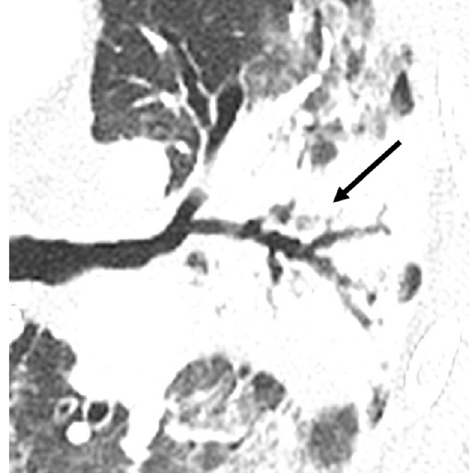
Fig. 15 Staphylococcus epidermidis . Sepsis. Consolidation with air bronchogram ( arrow )